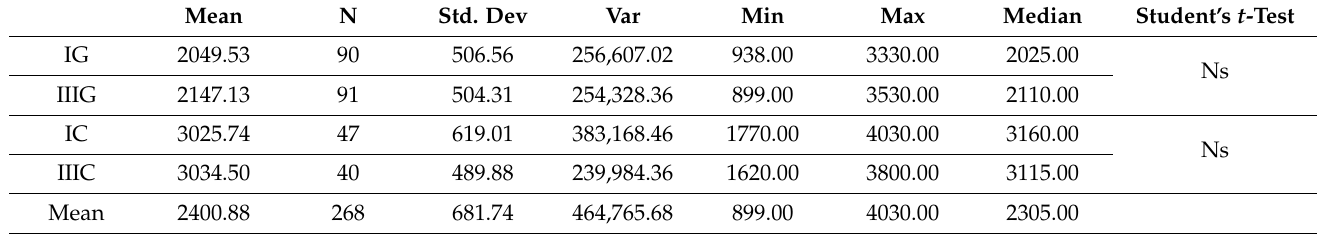
Table 5. Basic statistical parameters for the modulus of elasticity [MPa] and results of the Student’s t -test for samples collected from the ground section (G) and breast height (C) from both trees.